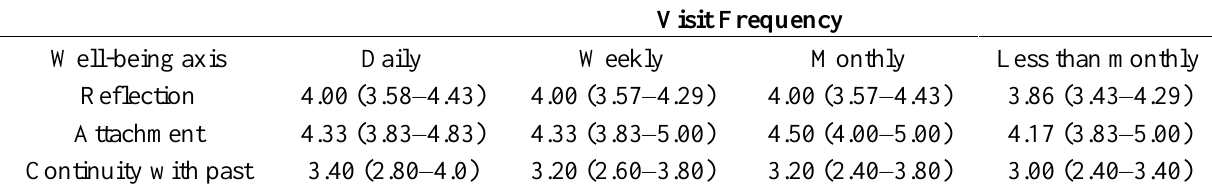
Table 2. For 1108 visitors to 34 riparian greenspaces in Sheffield, England, median (interquartile range) self-reported psychological well-being for three axes, according to the frequency with which participants visit the study greenspace.